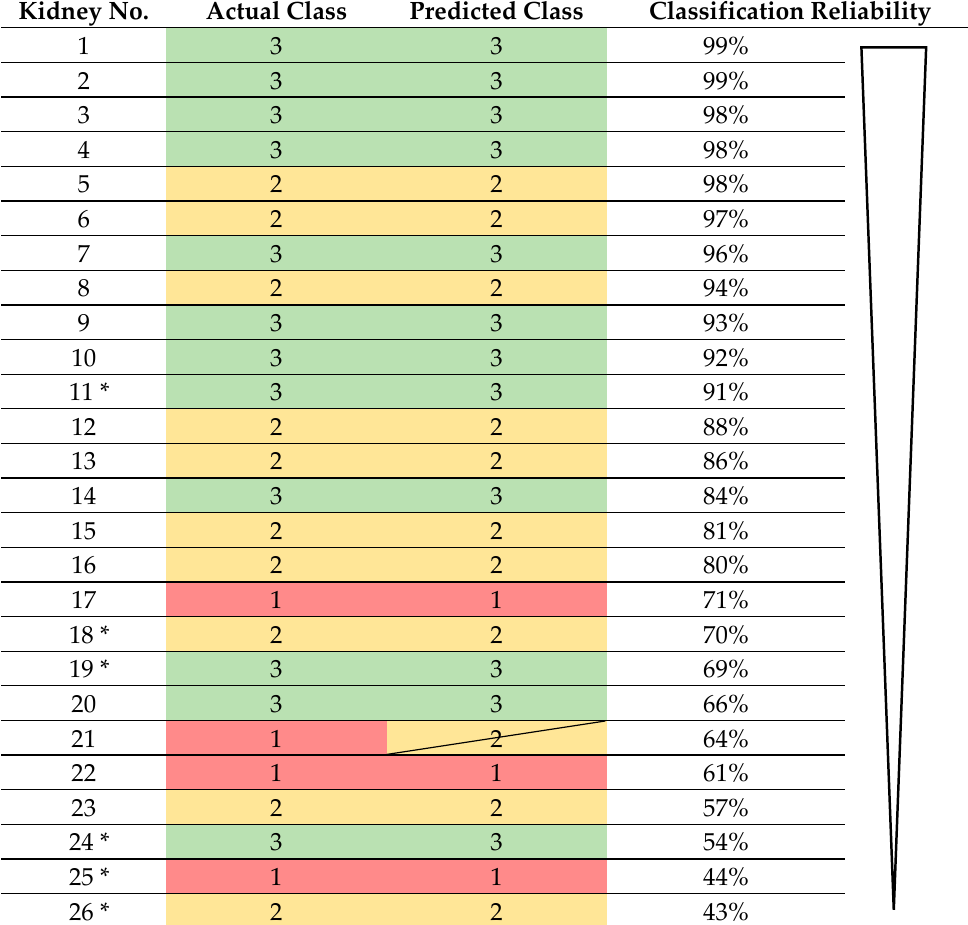
Table 9. Overview of the 3-class division of kidneys with a KidneyResNet. The kidneys of the test data set are marked with *. Note that all kidneys without * were part of the training process. The color coding corresponds to the functional status of the kidneys: red = nonfunctional kidneys (class 1), yellow = limited functional kidneys (class 2), green = functional kidneys (class 3). The actual class refers to the functional classes of the kidneys as determined by the clinical gold standard, which is compared to the predicted class resulting from the KidneyResNet analysis. In addition, the classification reliability is presented, which corresponds to the proportion of correctly classified ROIs of a kidney. A diagonal line represents kidneys that could not be assigned to the correct functional class. Kidney No. Actual Class Predicted Class Classification